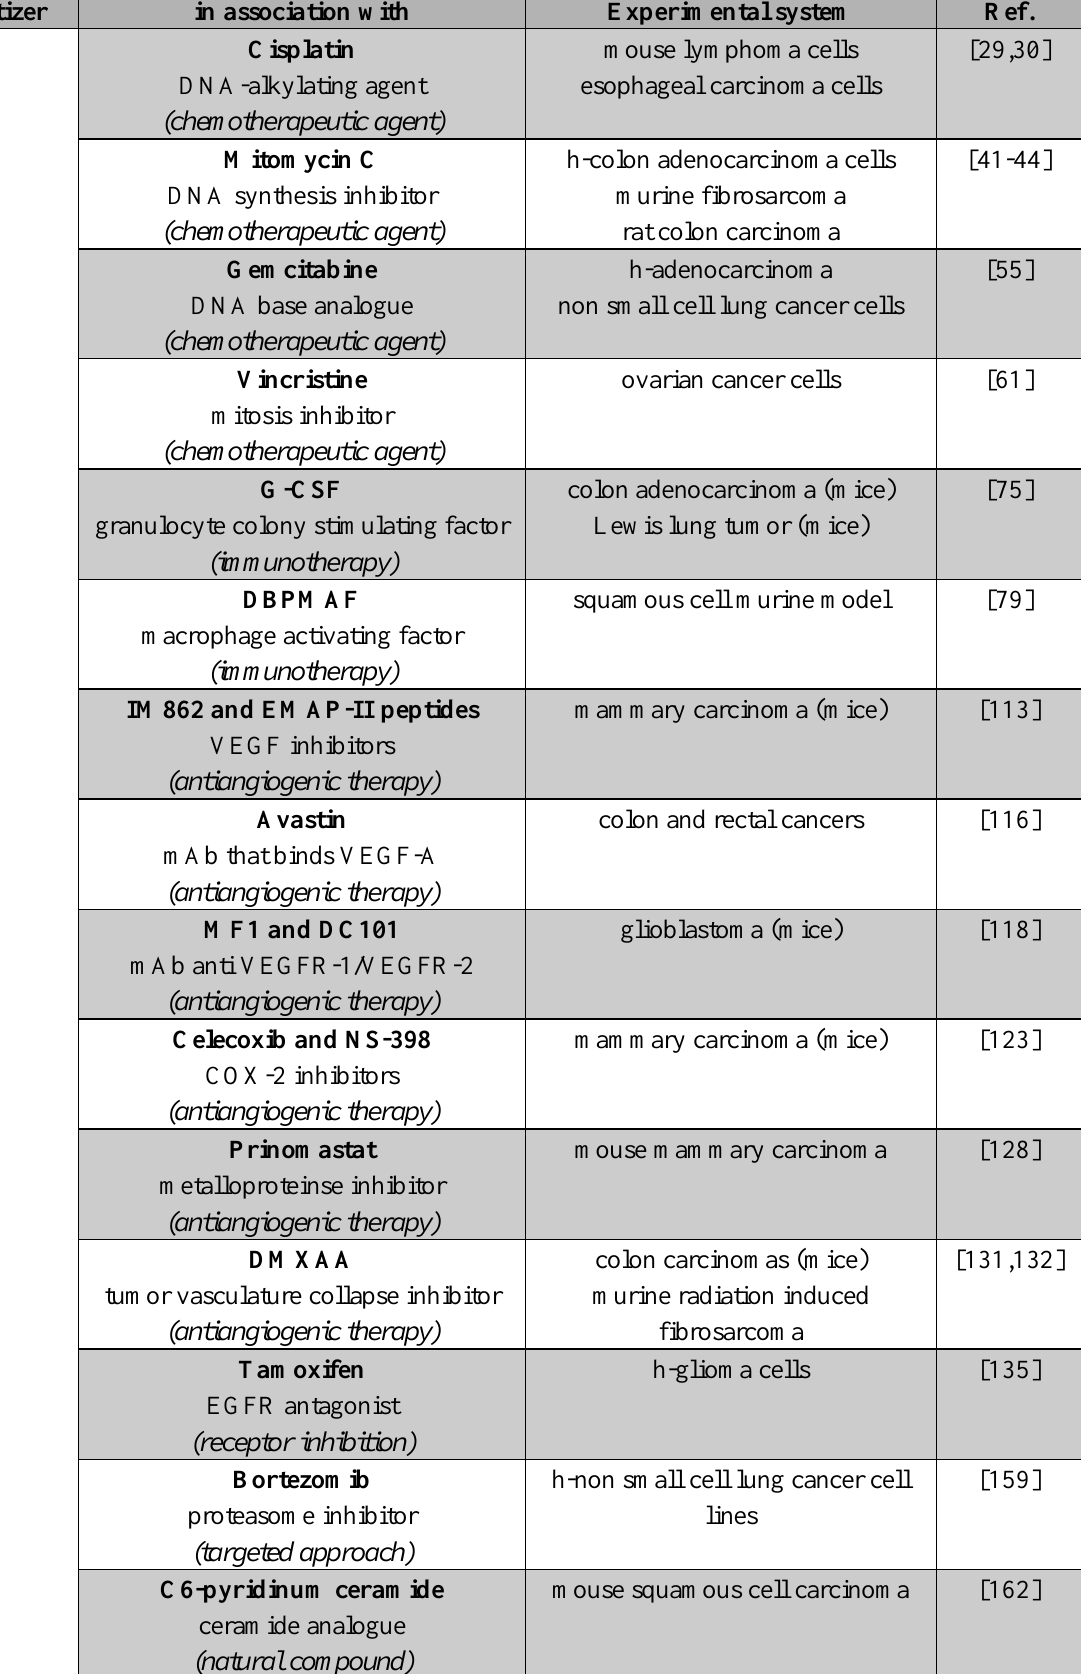
Table 2. Principal types of associations and experimental systems. Photosensitizer in association with